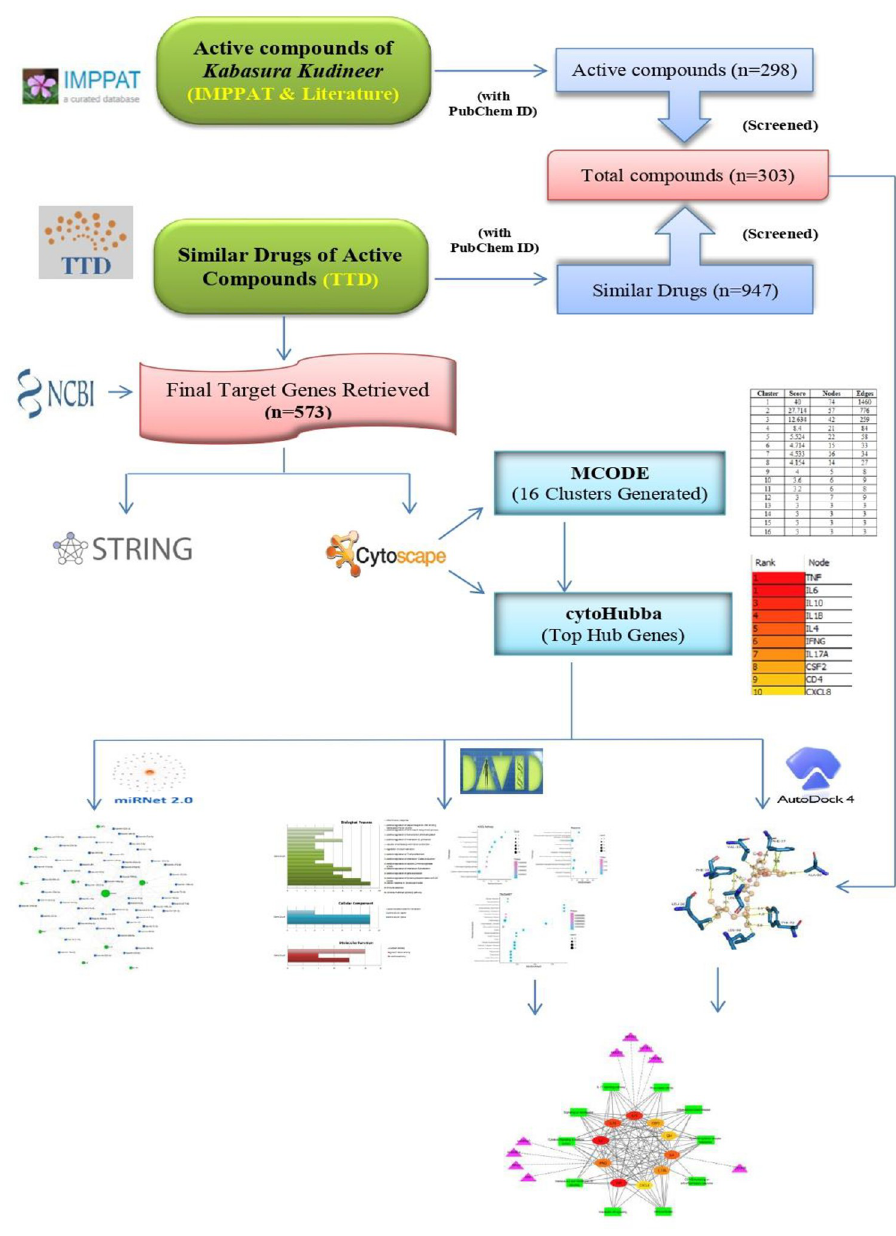
Fig 1. Flow chart of this research